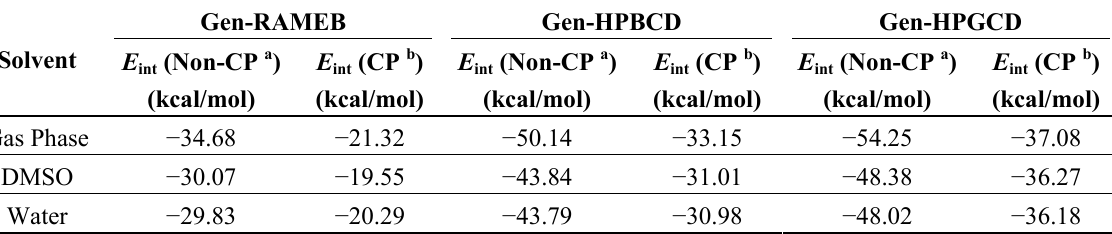
Table 1. Interaction energy of the three complexes.